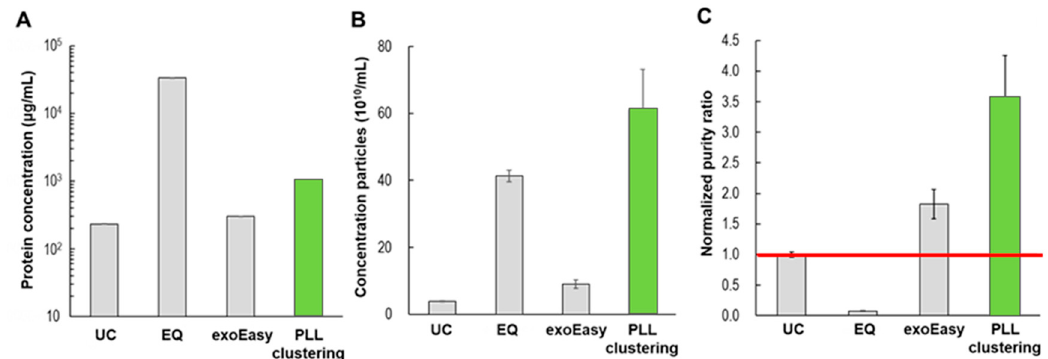
Figure 6. Comparison of EV isolation methods (UC, EQ, exoEasy, PLL) in terms of ( A ) protein concentration, ( B ) particle concentration, and ( C ) normalized purity ratio (particle / protein ratio). UC: ultracentrifugation, EQ: ExoQuickTM (SBI), exoEasyTM (Qiagen), PLL clustering: present study.